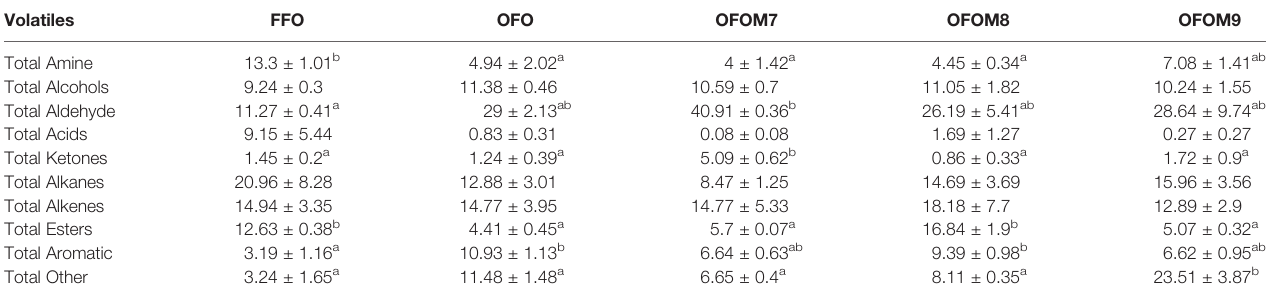
TABLE 8 | Muscle volatile compounds composition of grouper fed different diets (%).